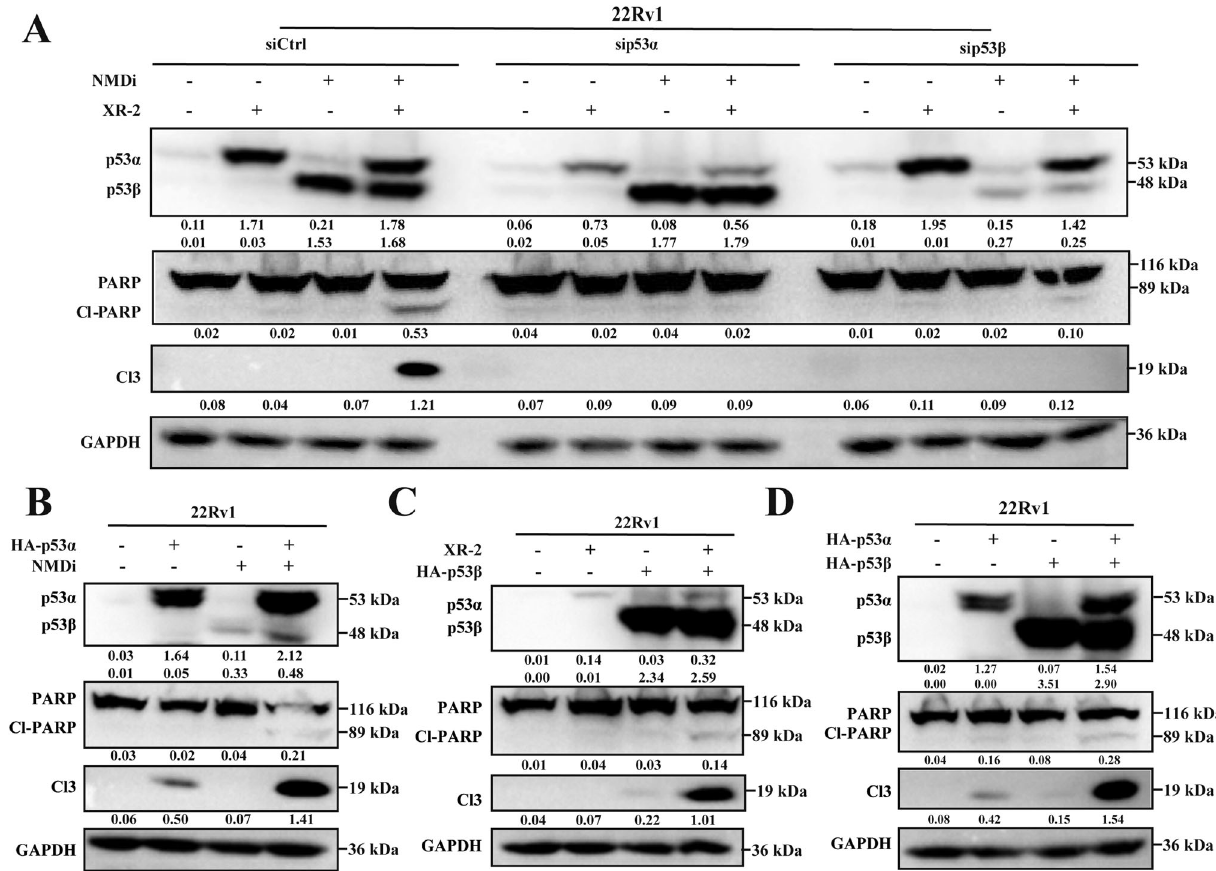
Fig. 5 Synergistic effect of the combination of XR-2 and NMDi is dependent on the cooperation between p53 α and p53 β . A 22Rv1 cells were treated with siCtrl, sip53 α , sip53 β and the cells were treated with 3.2 µM NMDi and 3.2 µM XR-2 alone or in combination for 24 h. Western blot was used to detect the protein levels of apoptosis markers and p53 isoforms. B 22Rv1 cells were transfected with 0.3 µg PCDH – HA – p53 α or PCDH backbone plasmid, followed by DMSO or 3.2 µM NMDi incubation for 24 h. The protein levels of apoptosis markers and p53 isoforms were analyzed by Western blot. C 22Rv1 cells were transfected with 0.3 µg PCDH – HA – p53 β or PCDH backbone plasmid. The cells were incubated with DMSO or 3.2 µM XR-2 treatment for 24 h, and the protein level of apoptosis markers and p53 isoforms were measured by Western blot. D Overexpression of p53 α or p53 β alone or in combination by 0.3 µg plasmid transfection on 22Rv1 cells. Western blot analysis was used to detect the protein level of apoptosis markers and p53 isoforms. Comb: combination treatment group. Cl-PARP cleaved PARP, Cl3 cleaved Caspase